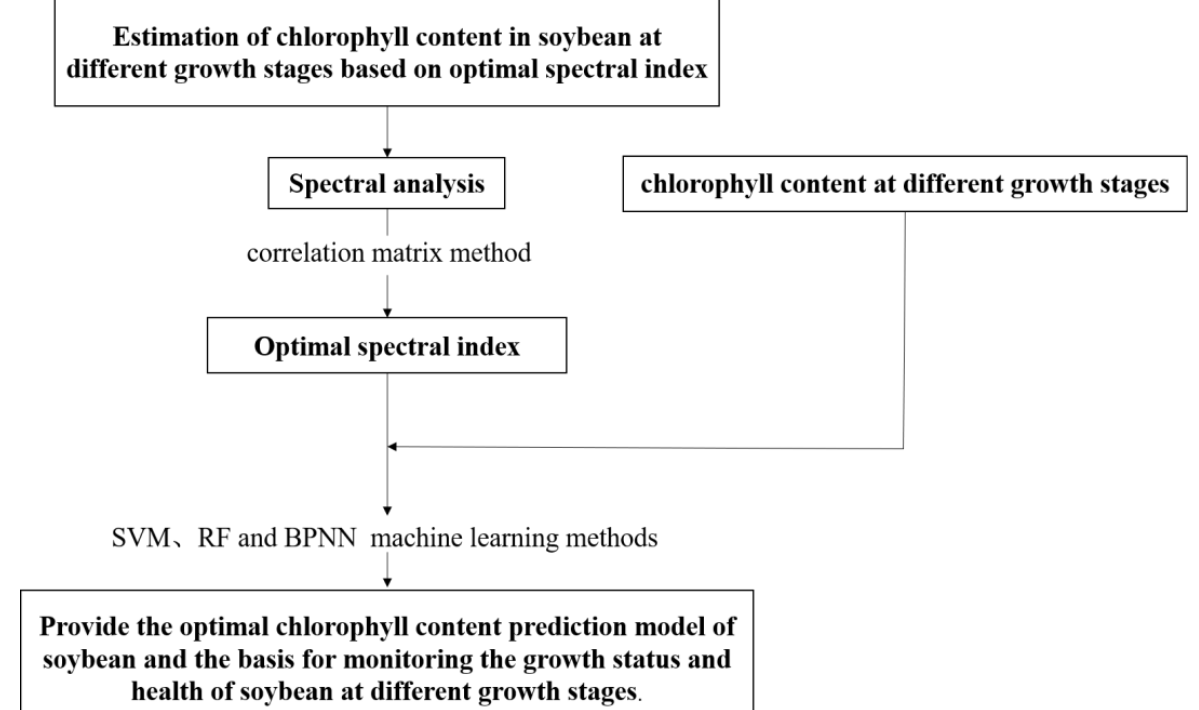
Figure 3. Diagrams of architectures used in the experiments.